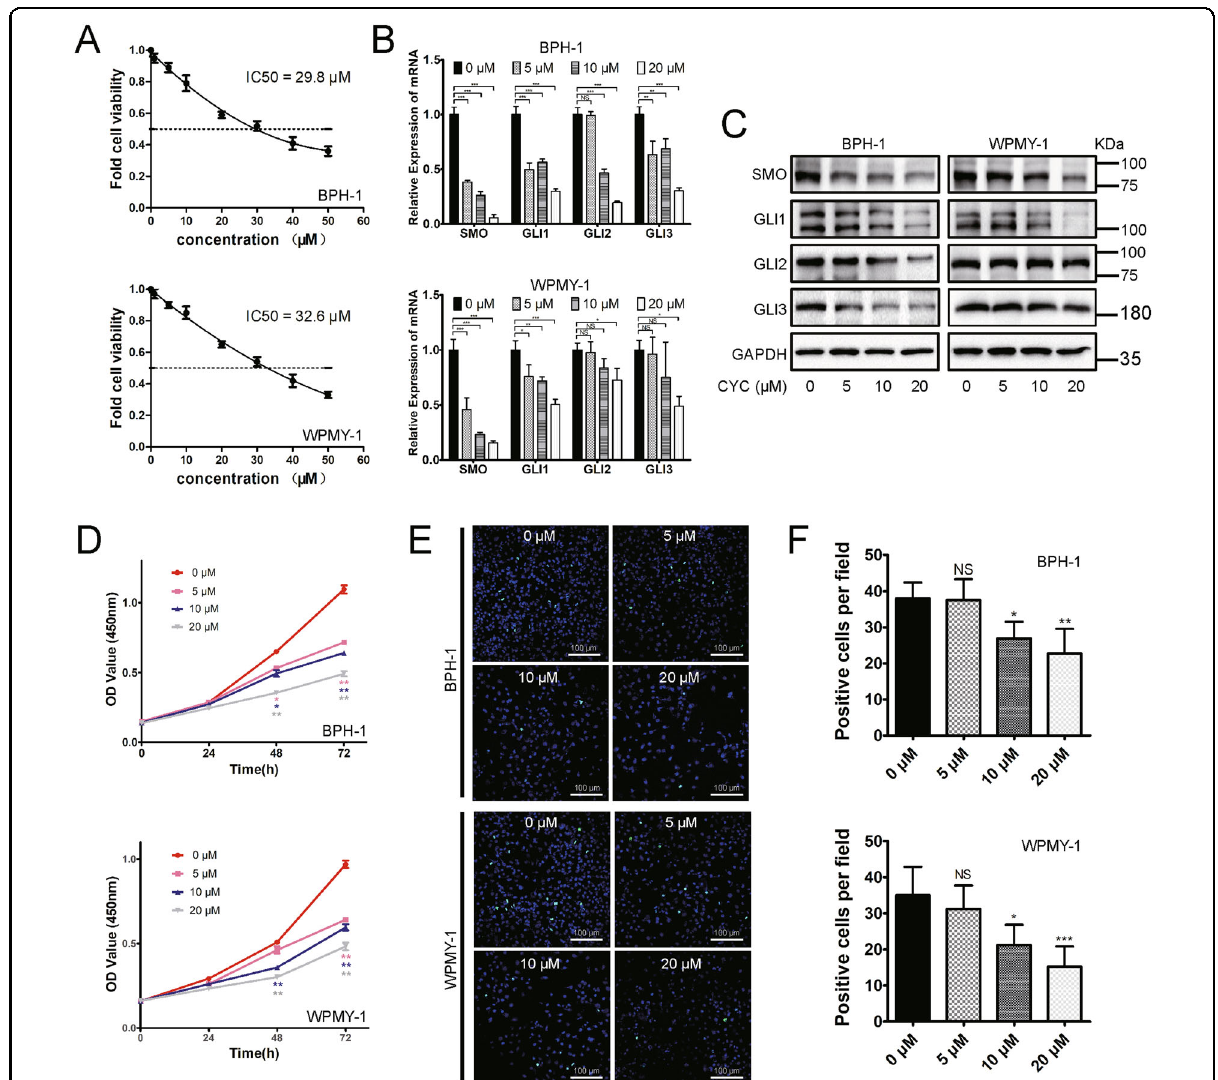
Fig. 3 Typical dose – response curves for the inhibition of proliferation by CYC in BPH-1 and WPMY-1 cells. A The inhibition of proliferation by CYC from 0 to 50 μ M, the IC50 for the cytotoxic effect of BPH-1 and WPMY-1 cells is 29.8 and 32.6 μ M, respectively. B , C The relative mRNA and protein level of SMO, GLI1, GLI2, and GLI3 in BPH-1 and WPMY-1 after CYC treated. D The cell viability of BPH-1 and WPMY-1 after CYC treated at different time points by CCK-8 assay. E The Ki-67 staining of BPH-1 and WPMY-1 after CYC treated. F Statistical analysis of Ki-67-positive cells per fi eld in BPH-1 and WPMY-1 after CYC treated. For 5, 10, and 20 μ M CYC compared with 0 μ M CYC, NS means no signi fi cant difference, * p < 0.05, ** p < 0.01, *** p < 0.001; one-way ANOVA. The scale bars are 100 μ